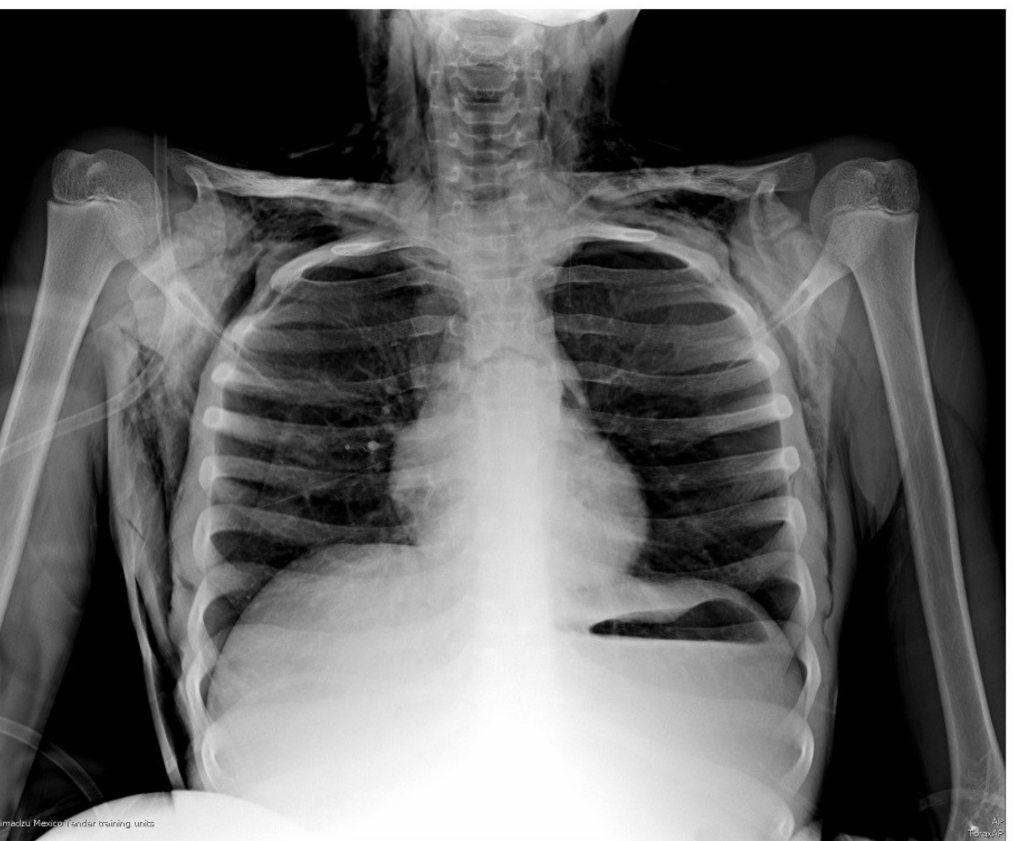
Figure 1. Plain chest radiograph in anteroposterior projection on admission of patient to the ED. A small pneumothorax can be observed in the upper right part of the left hemithorax of approximately 20%, as well as signs of pulmonary hyperinflation, with horizontalization of the costal arches; subcutaneous emphysema can also be observed in the neck and both hemithorax. Unable to visualize the